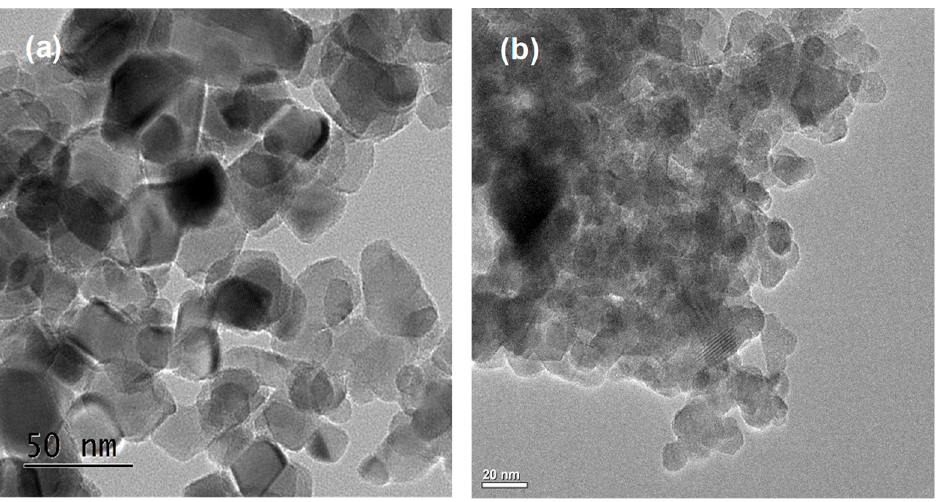
Figure 3. TEM images of ( a ) TiO 2 (P25) and ( b ) NNT-P photocatalysts.